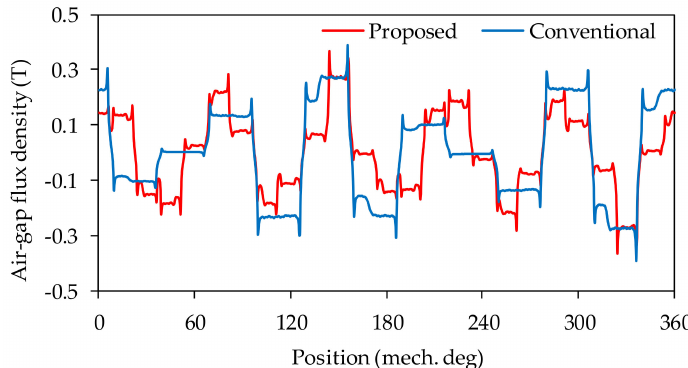
Figure 13. Air gap flux densities of the armature reaction fields of the two compared machines.